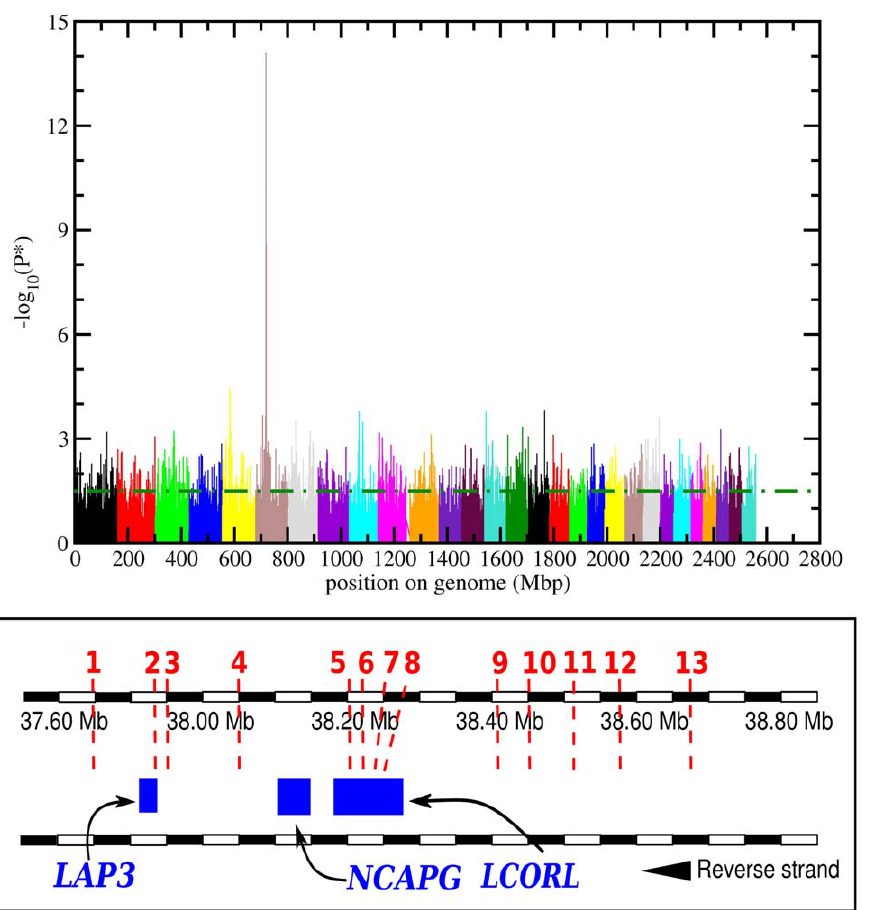
Figure 2. Upper panel: log significance levels of SNPs association with direct calving ease for the entire filtered dataset before the correction for inflation. Each autosome is represented with a different colour and position is calculated along the entire genome length. Values above the dot-dashed green line denote a P* , 0.05. Lower panel: The chromosomal region spanned by the 13 markers listed in Table 1. The approximate position and size of genes located in the region (blue rectangles) together with the position of each SNP (red numbers and red dashed lines) are shown.